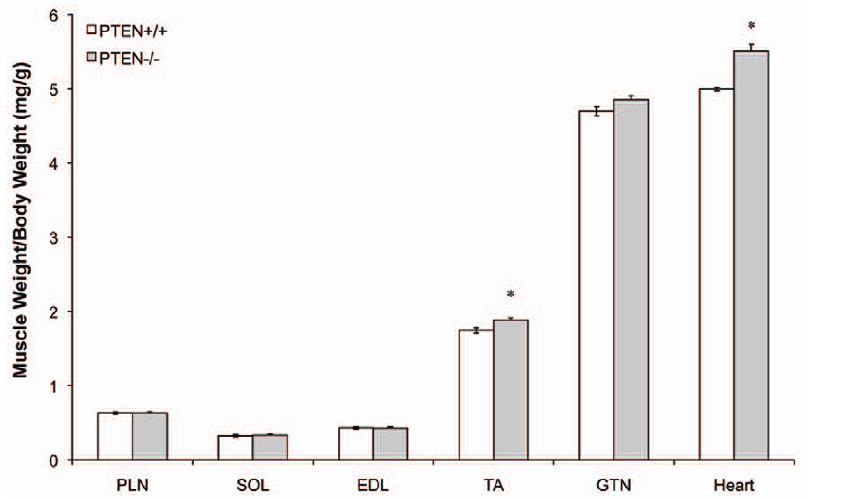
Figure 3. Alterations in striated muscle mass in PTEN knockout mice. The mass of select striated muscles relative to body mass was determined for PTEN + / + (n=19) and PTEN 2 / 2 mice (n=20). * Indicates significantly different from wild type (p , 0.05).